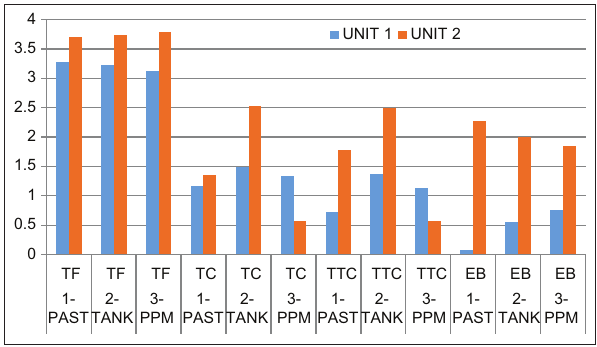
Figure-1: Distribution of the indicators along the production line for both units. Total microbial flora, total coliforms, thermotolerant coliforms, and Enterobacteriaceae. Table-1: Compliance rate of bacterial contamination of milk in both units. Sample